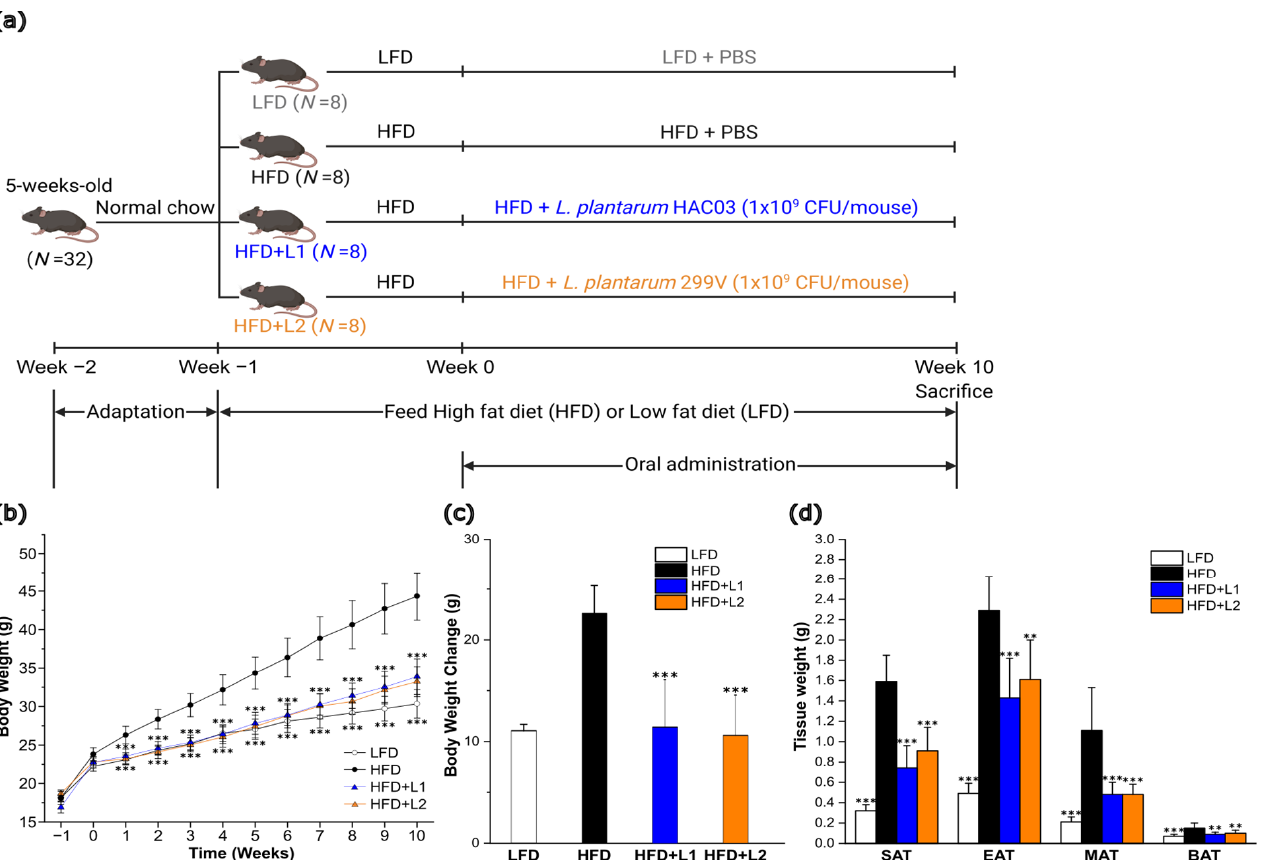
Figure 1. L. plantarum HAC03 has an anti-obesity effect. ( a ) Scheme of animal experiment. LFD: Low-fat diet, HFD: High-fat diet, HFD + L1: High-fat diet with L. plantarum HAC03 treatment, HFD + L2: High-fat diet with L. plantarum 299V treatment. ( b ) Body weight changes during the animal experiment. ( c ) Weight gain during the animal experiment. ( d ) Adipose tissue weight after 11 weeks of L. plantarum HAC03 or L. plantarum 299V treatments. The data are presented as mean ± SD ( n = 8). A one-way ANOVA with Dunnett’s test was used for comparison with HFD groups. ** p < 0.01, *** p < 0.001.